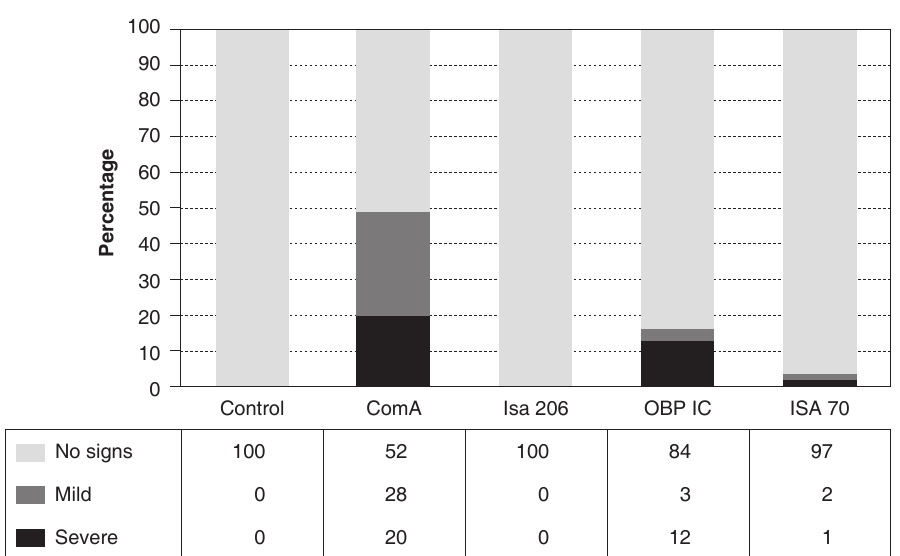
Graphic representation of the vaccination reactions obtained after the second vaccination with the different vaccines used in